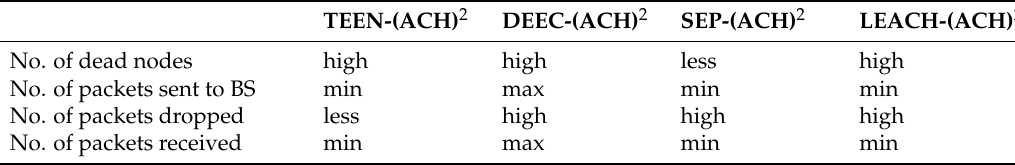
Table 5. Scenario-III: Performance of proposed schemes.